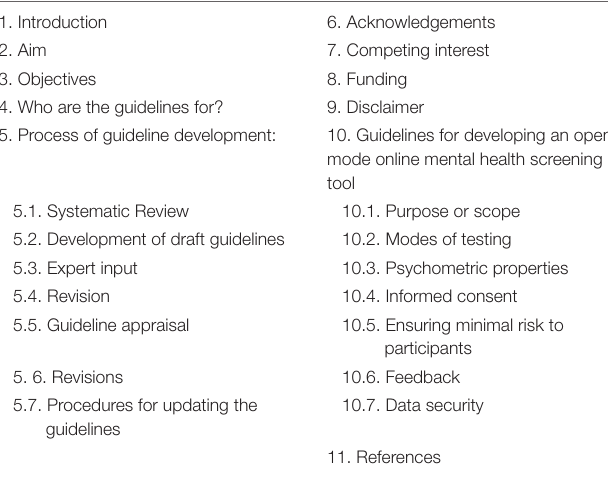
TABLE 1 | Overview of the guidelines